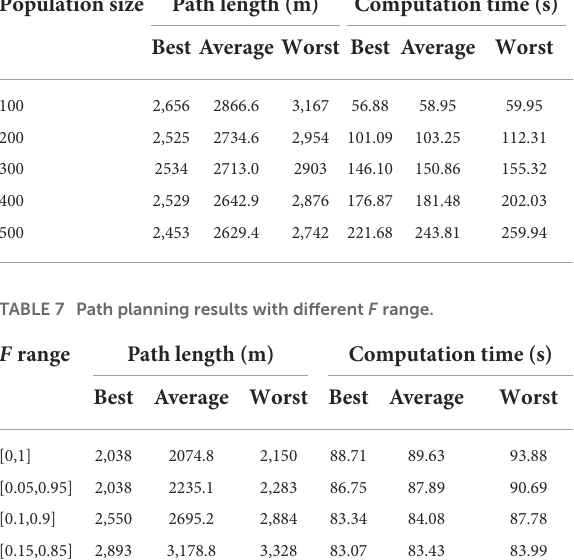
TABLE 6 Path planning results with different population sizes. Population size